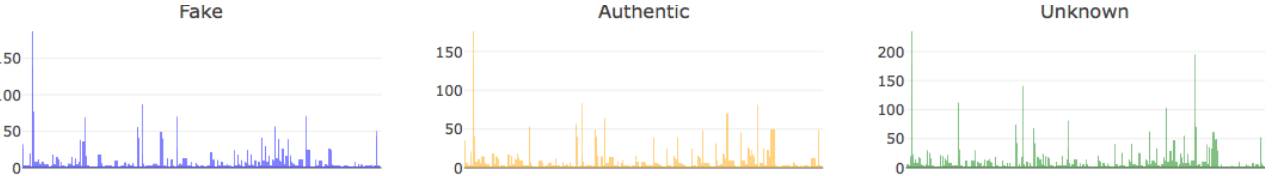
Figure 4. Spectrum distributions of subpaths in trees. Detection is carried out based on which the distribution of an unknown site is more similar to, the distribution for a fake site or the distribution for an authentic